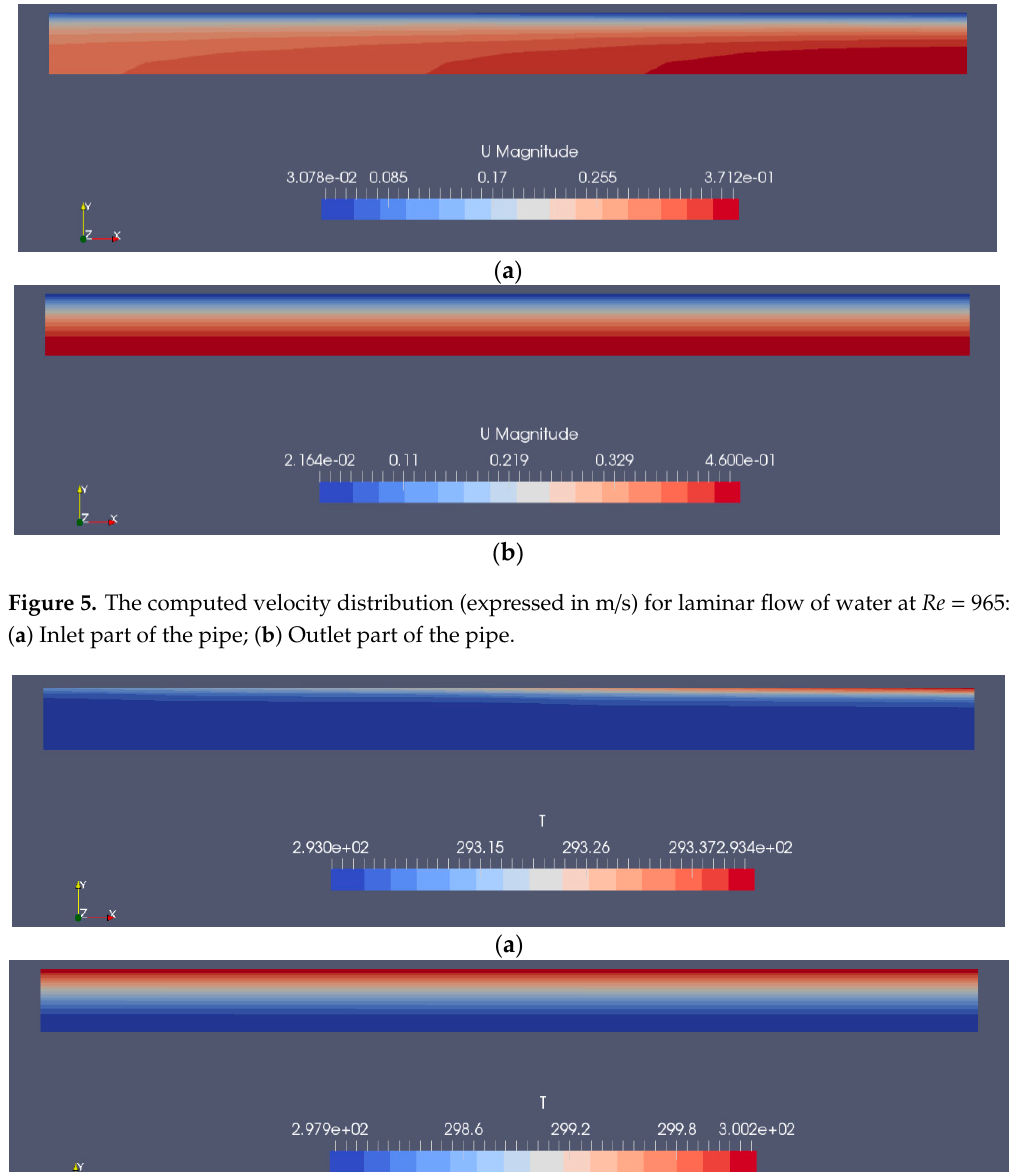
Table 2. Parameters used for the simulation scenarios for ethylene glycol-based silicon nitride (EG- Si 3 N 4 ) nanofluid.